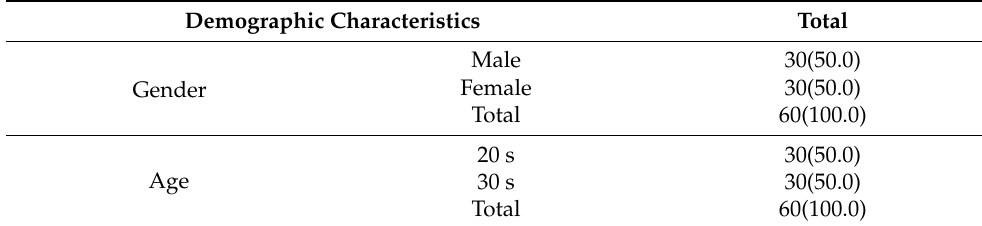
Table 2. Demographic Characteristics